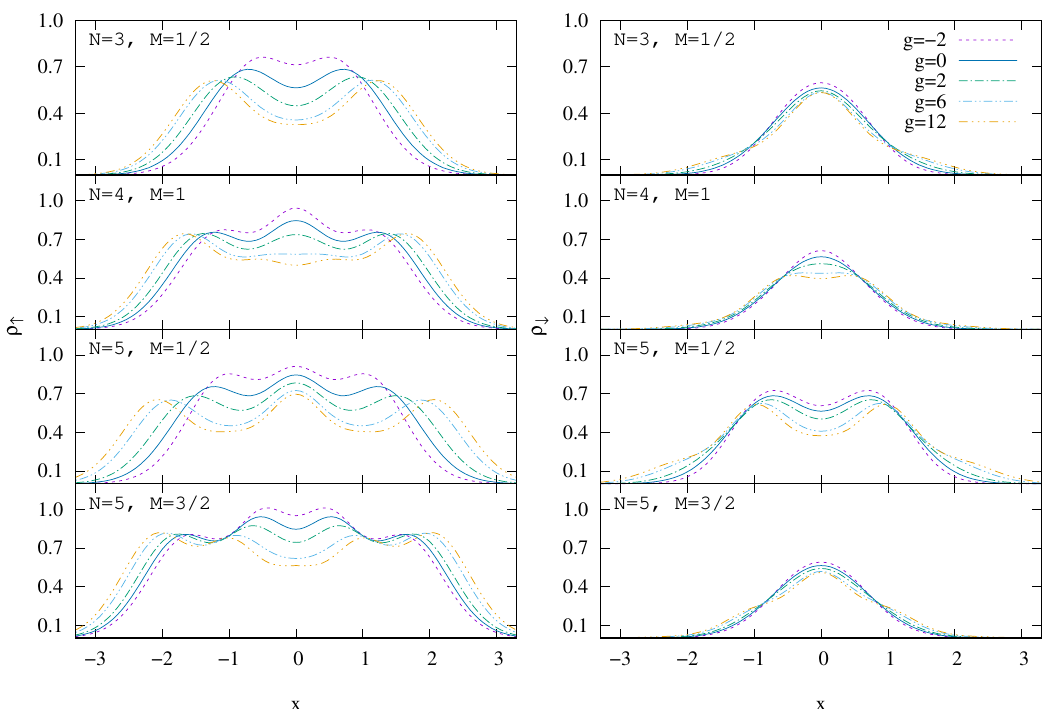
Figure 6. Densities of the spin up ( ρ ↑ , left panels) and spin down ( ρ ↓ , right panels) particles in the ground state. The density profiles are shown for various values of the interaction strength and for different number of particles and spin projection. The legend is common to all panels. The corresponding total densities are reported in Figure